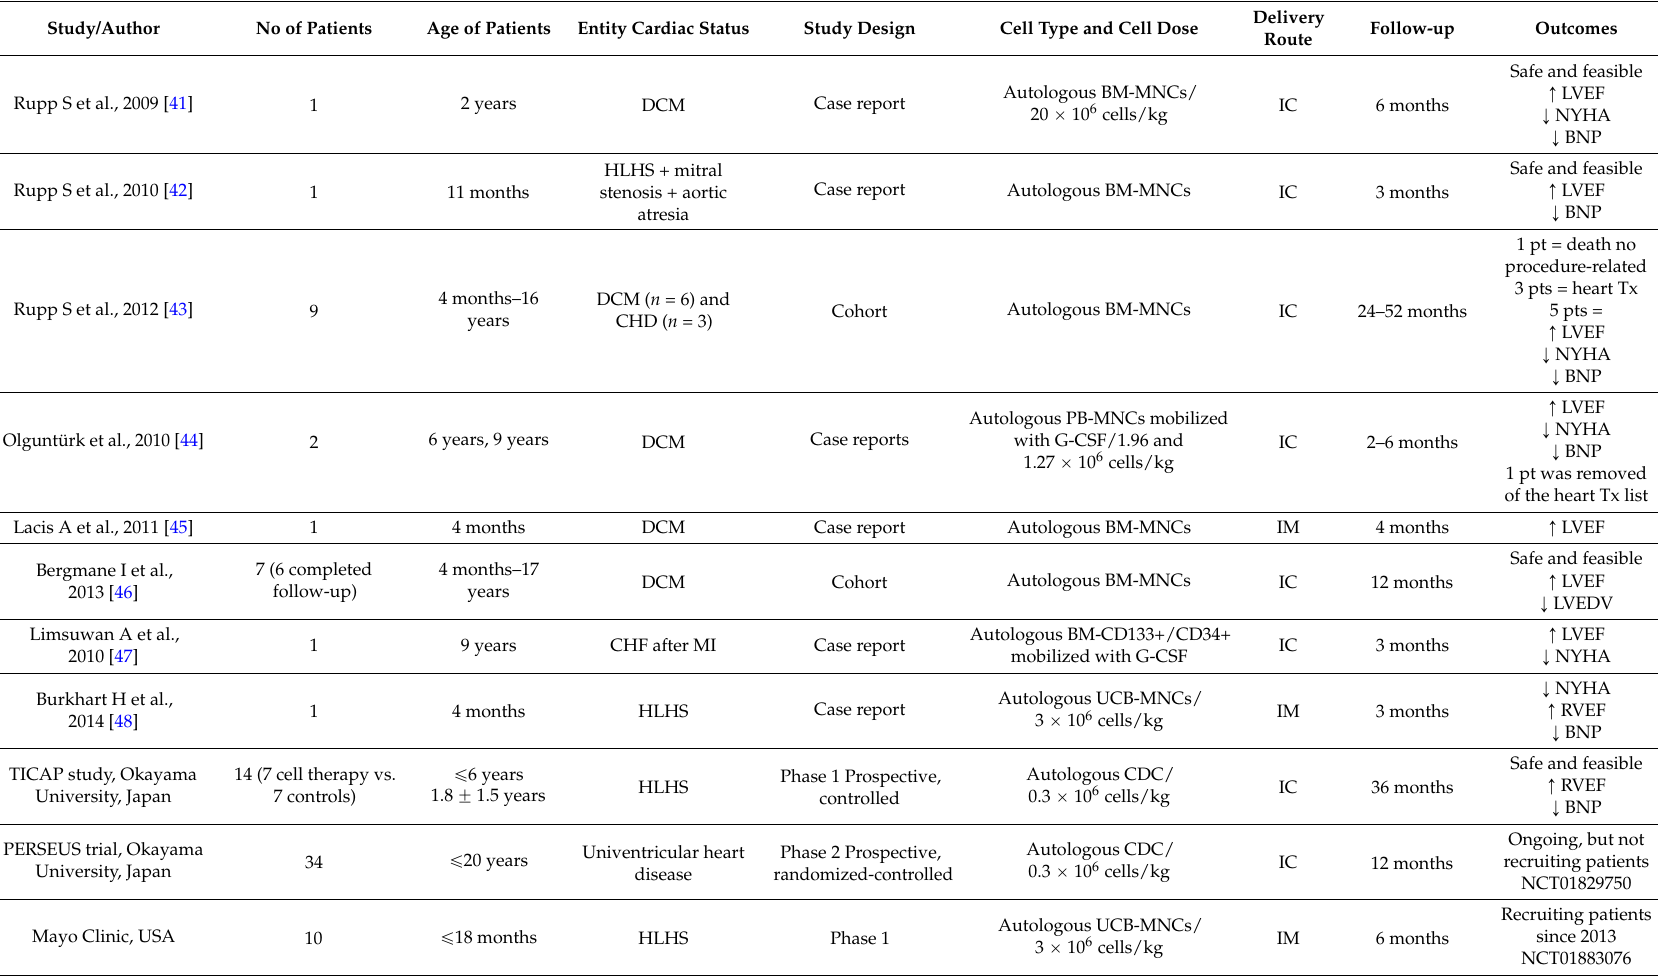
Table 4. Case reports and clinical trials of stem cell-based therapy in children with CHD and/or heart